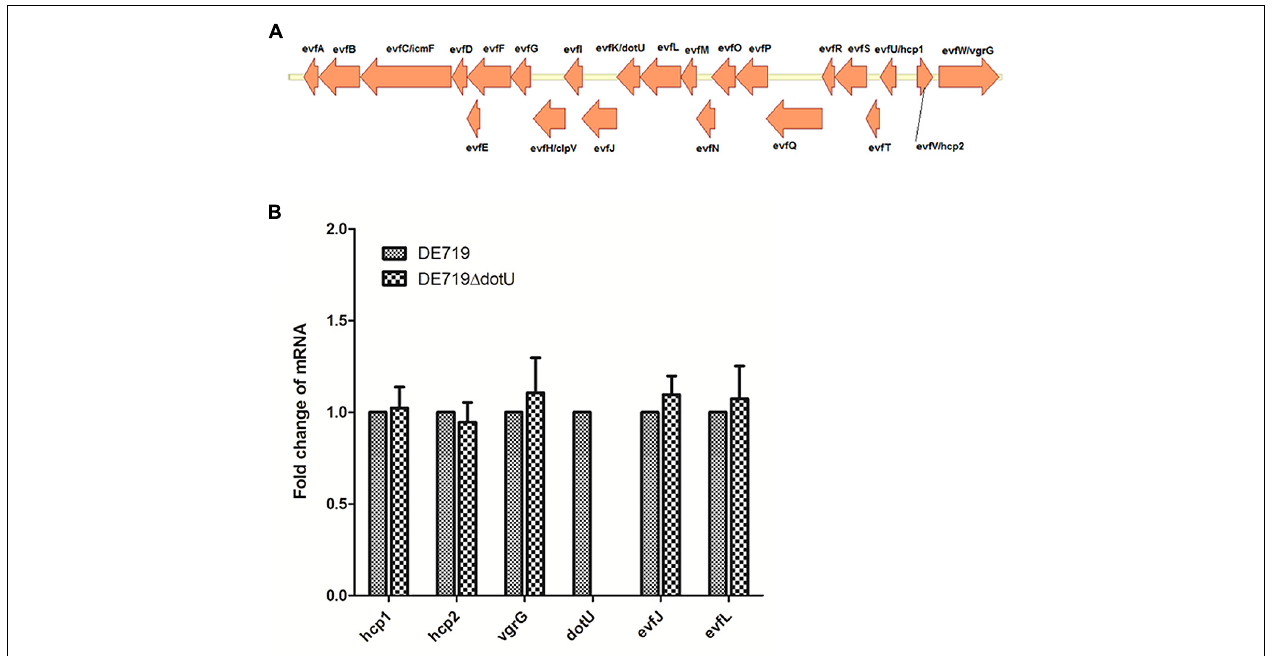
FIGURE 1 | (A) Schematic diagram of the genetic organization of APEC DE719T6SS2 gene clusters.TheT6SS2 whole-gene cluster of ORFs with different direction is shown. (B) Quantification ofT6SS2 core genes